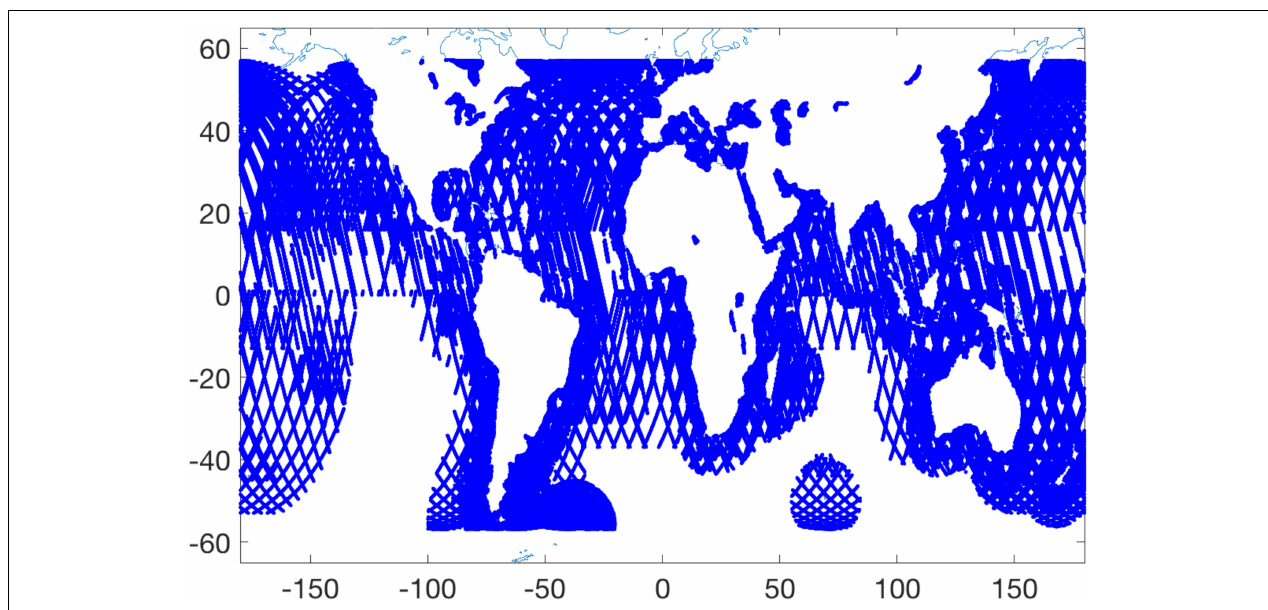
FIGURE 10 | Possible coverage of coastal areas from SoOp LEO satellites receiving commercial Ku-band transmitters. This figure shows the extent of the coverage in coastal